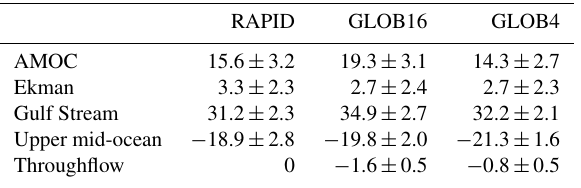
Table 1. AMOC and its constituents with standard deviations, aver- aged within the 2009–2013 period as obtained from RAPID obser- vations and the two models at 26.5 ◦ N. The modelled Gulf Stream transports include both the Florida Current and western boundary current